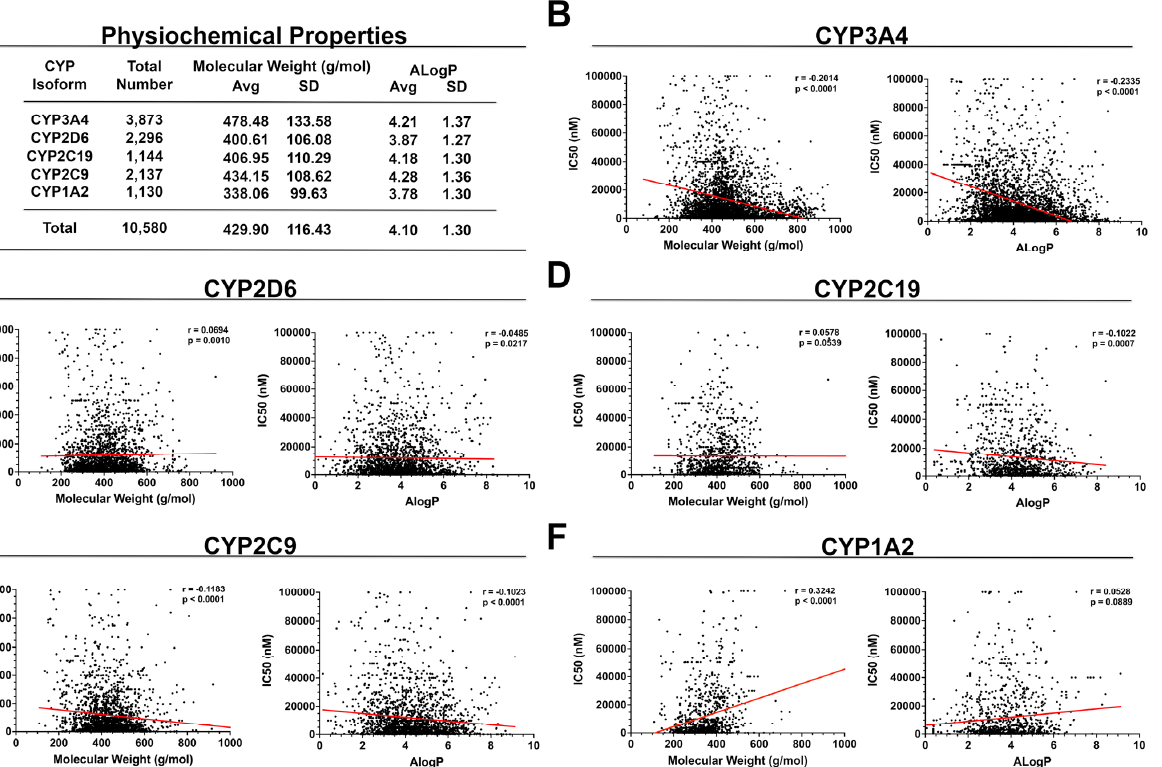
Figure 2. Summary of the physiochemical properties of major cytochrome inhibitors and their impact on half-maximal inhibitor concentration (IC 50 ). ( A ) Molecular weight and lipophilicity of validated inhibitors of each individual cytochrome. ( B – F ) Graphs representing IC 50 versus either molecular or ALogP for CYPs 3A4 ( B ), 2D6 ( C ), 2C19 ( D ), 2C9 ( E ), and 1A2 ( F ). CYP3A4 and CYP2C9 inhibitors demonstrated a weak statistically significant negative relationship between molecule size, lipophilicity, and IC 50 (i.e., larger, more lipophilic molecules, tend to have lower IC 50 values); however, the exact opposite trend was observed for CYP1A2. No relationship was identified for CYPs 2D6 and 2C19.